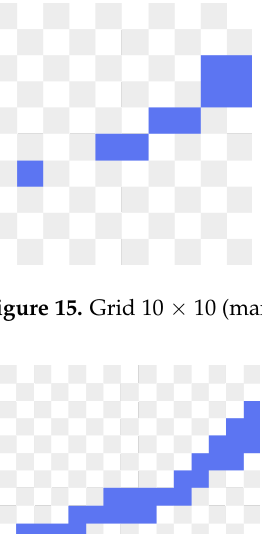
Figure 15. Grid 10 × 10 (manual — skilled operator).